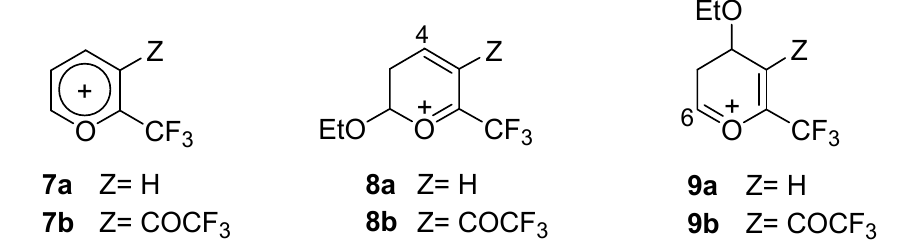
Figure 1. Cations 7a , b , 8a , b , and 9a , b